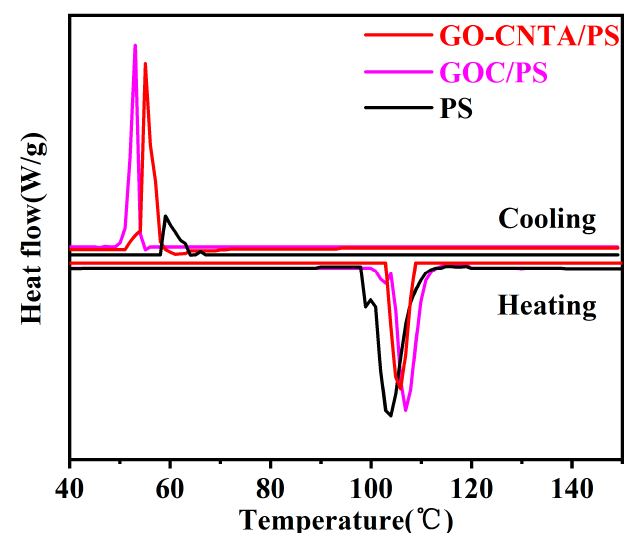
Figure 11. DSC curves of PS, GOC/PS and GO-CNTA/PS.